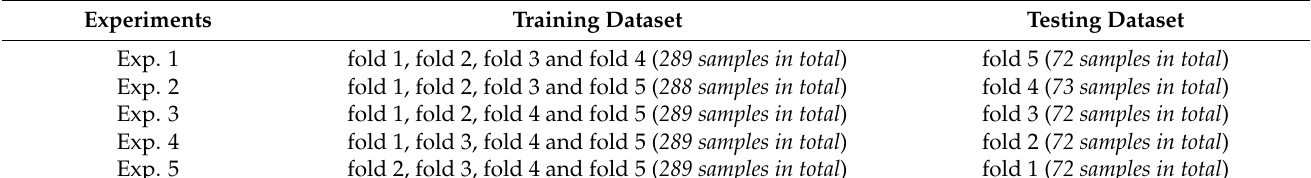
Table 5. Experiment settings with different fold partitions.